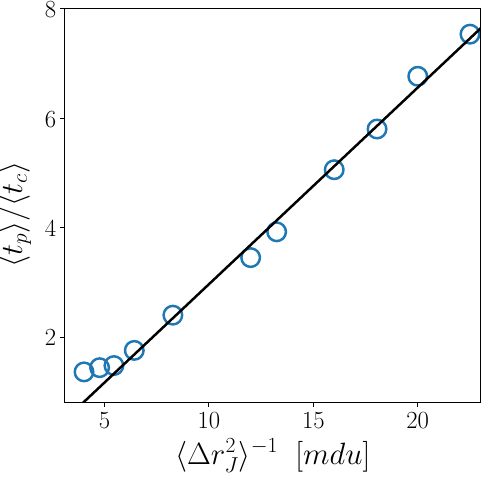
∆ r 2 1 . Solid line represents a linear versus j (cid:105) − t c (cid:104) (cid:104) (cid:105)